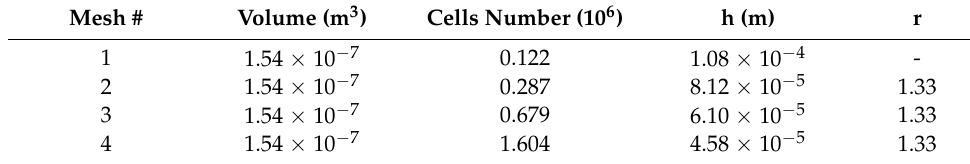
Table 2. Mesh data for grid convergence